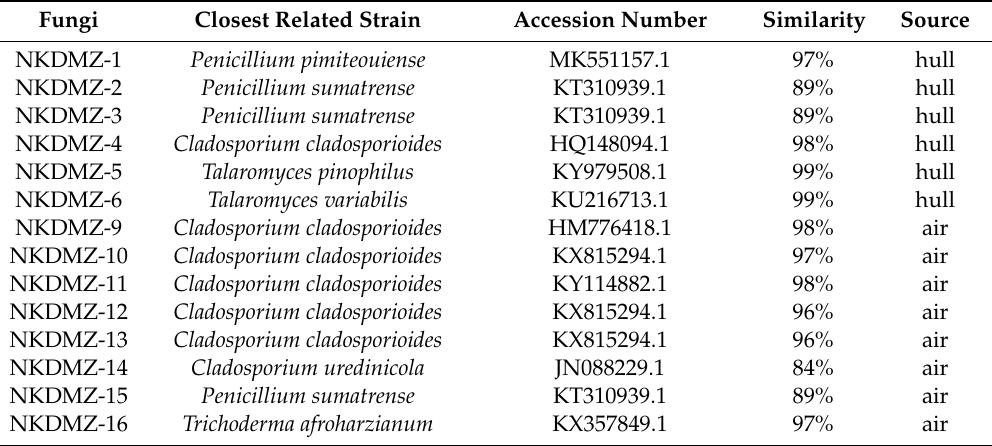
Table 1. Molecular identification of strains isolated from the pirogue and